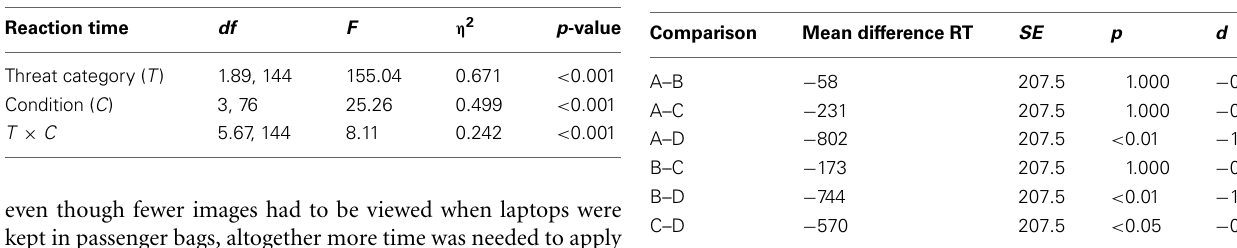
FIGURE 8 | Mean reaction times (s) with standard errors of the mean for all four conditions (A–D) broken up by threat categories (guns, knives, IEDs, others). Table 4 | Results of the repeated-measures ANOVA conducted with reaction time (RT).